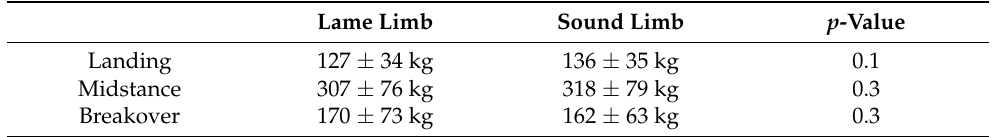
Table 5. Pairwise comparisons of the bilateral vertical force in kg between the sound and the lame limb after anaesthesia during landing, midstance, and breakover.